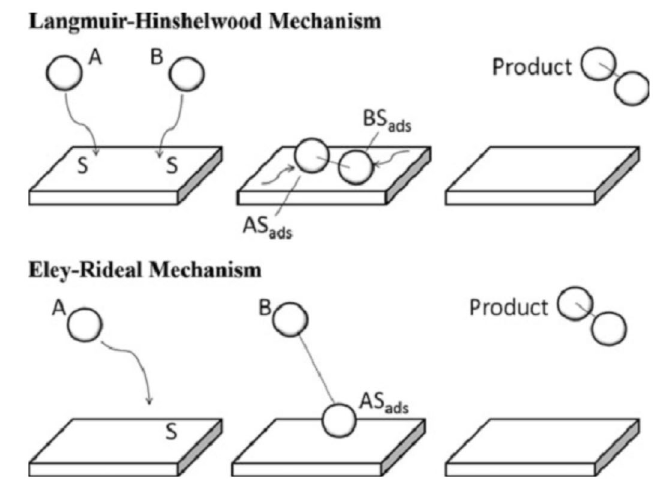
Figure 2. Top model: The Langmuir–Hinshelwood mechanism: two molecules adsorb onto the surface and diffuse and interact with each other until a product is formed and desorbs from the surface. Bottom model: The Eley–Rideal mechanism: a molecule adsorbs onto the surface and another molecule interacts with the adsorbed one until a product is formed and desorbs from the surface. Reprinted with permission from Ref. [46]. Copyright 2014 Springer Nature.